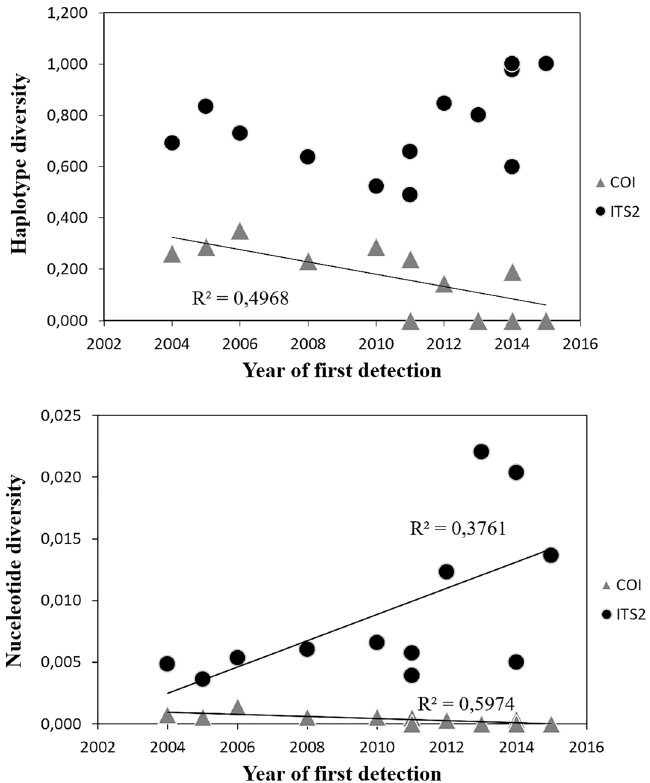
Figure 3. Relationship between genetic diversity and year of first detection in the analysed provinces. The mitochondrial COI fragment is indicated by grey triangles and the nuclear ITS2 gene by black circles. Only provinces with four or more samples were included in the analysis. See Table 1 for province